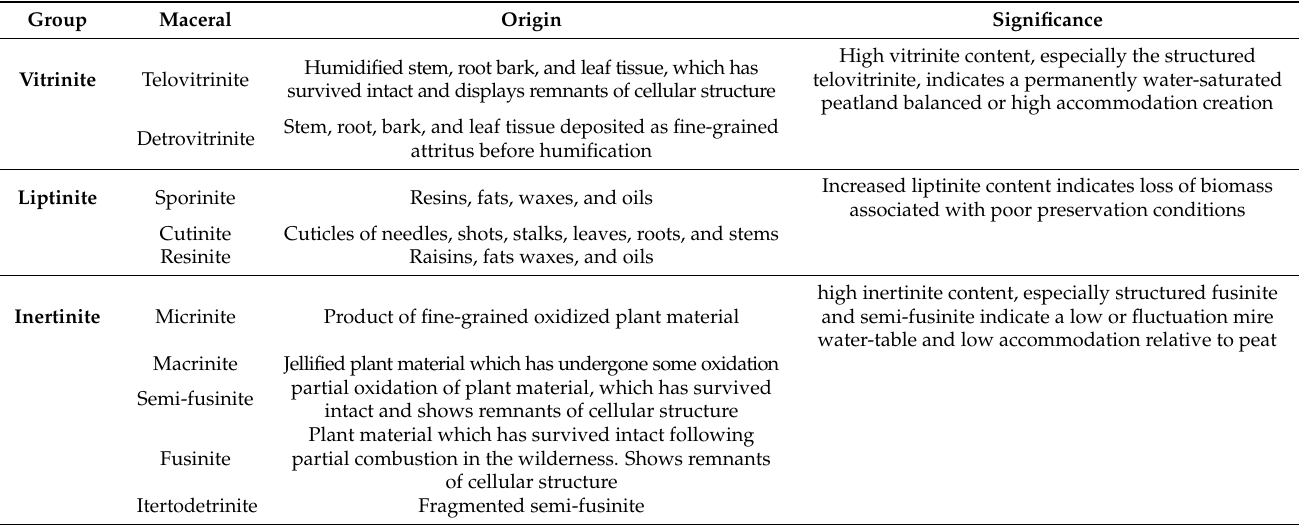
Table 3. Maceral groups and their origin